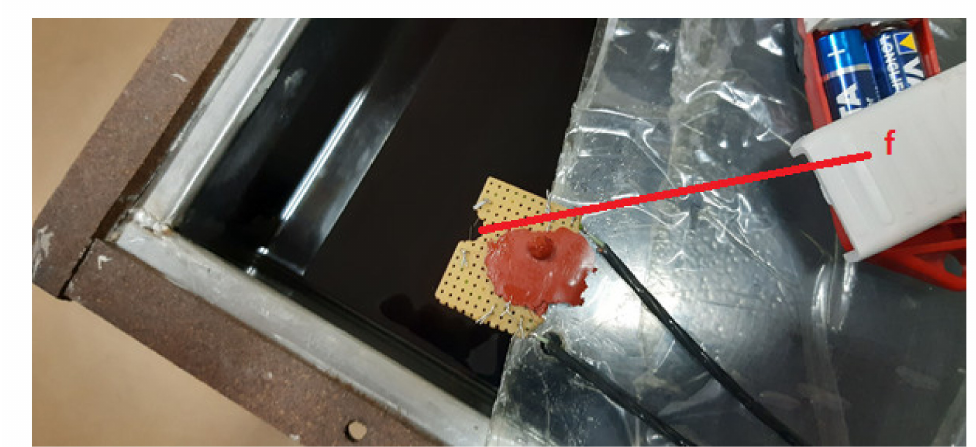
Figure 12. Photograph of the PD corona spark source ( f